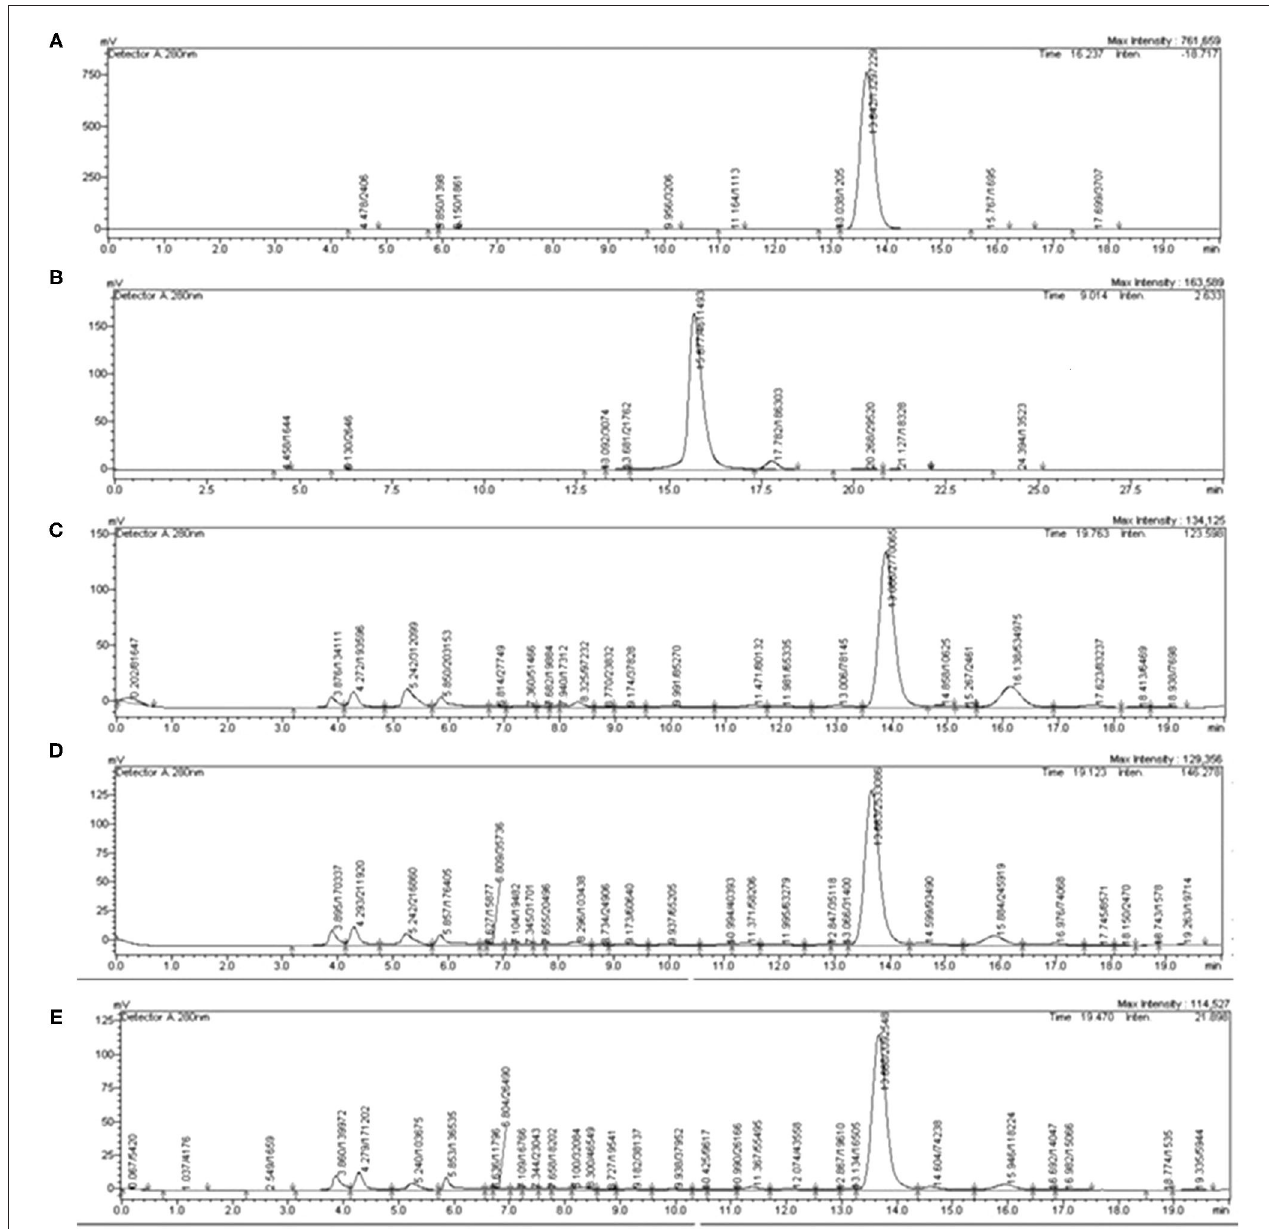
FIGURE 1 | Representative high-performance liquid chromatography (HPLC) chromatograms of (A) caffeine, (B) chlorogenic acid, (C) light coffee (LC), (D) medium coffee (MC), and (E) dark coffee (DC). Caffeine was detected at 280nm and chlorogenic acid was detected at 320nm.